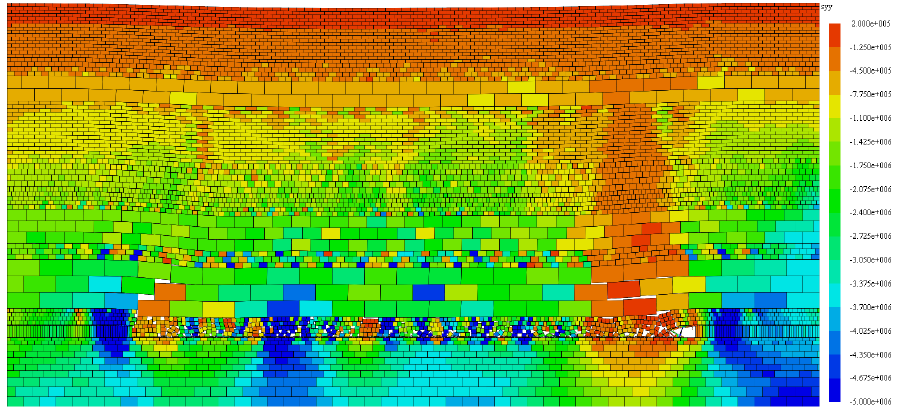
Figure 4. Basic roof caving form in excavation 200 m distance.